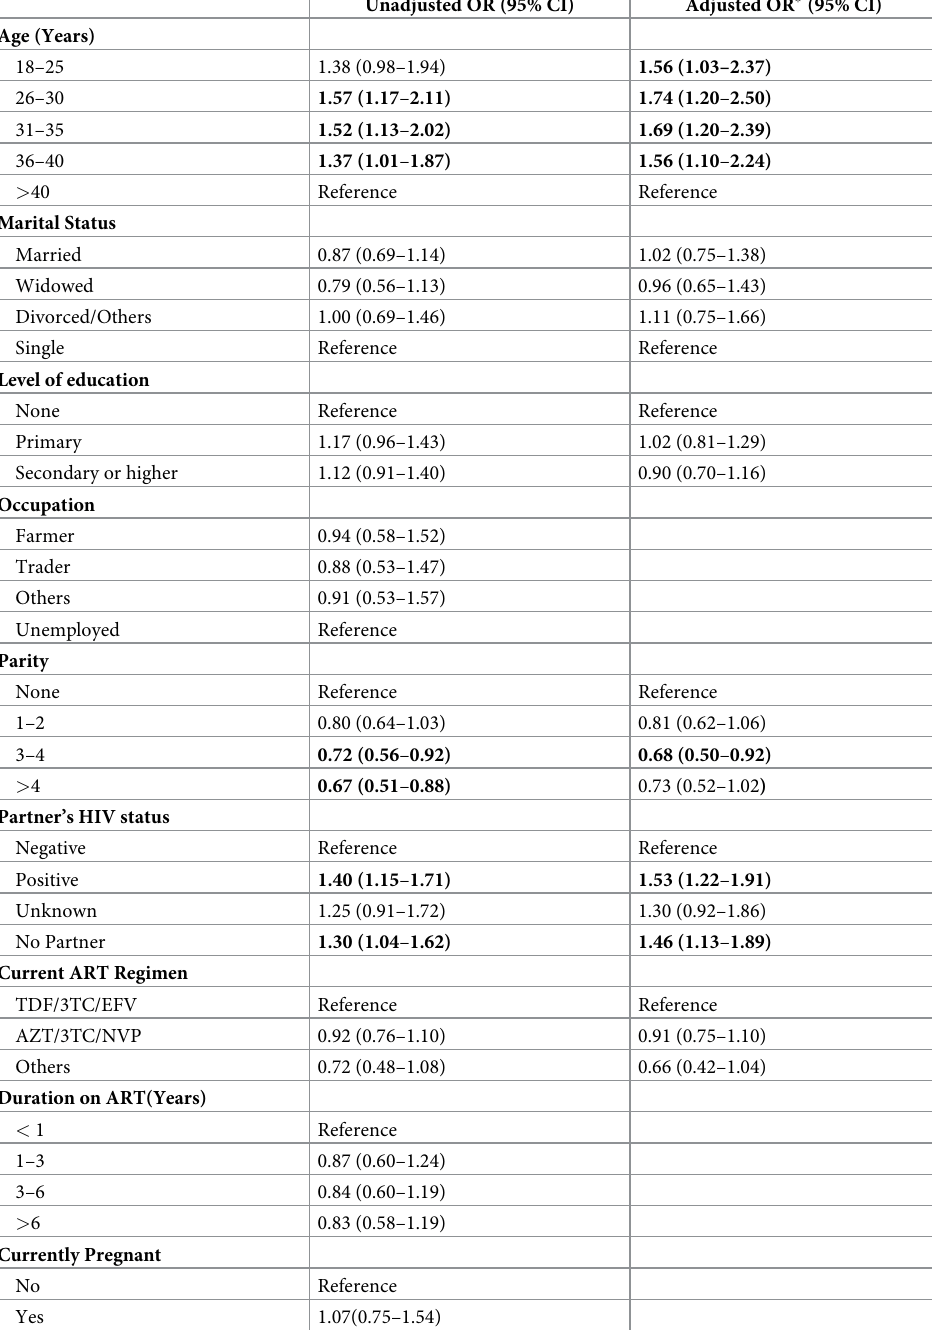
Table 3. Multivariable analysis of factors associated with HBV infection in female participants of patient-held smartcard scale-up study in Benue State, Nigeria (N =